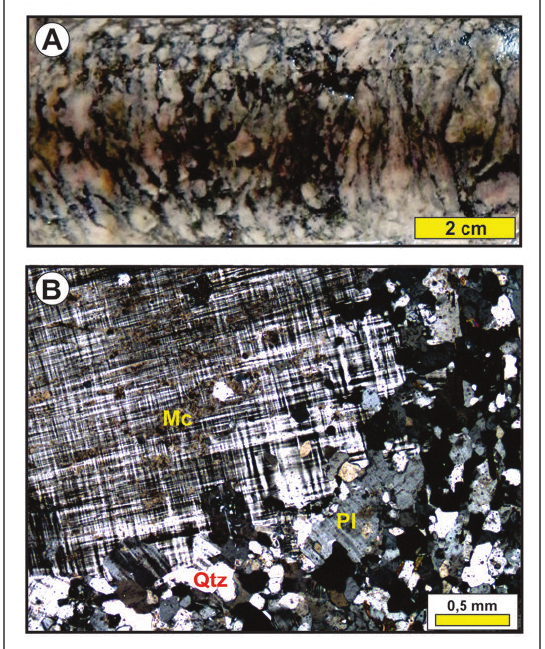
Figure 7 - Textural characteristics of the augen gneiss of the intermediate compartment. (A) drill-core showing the porphyroclastic texture; (B) photomicrograph showing microcline porphyroclasts immersed in mortar texture of quartz-feldspathic composition (crossed Nicols). Mc = microcline, Pl = plagioclase, Qtz = quartz.